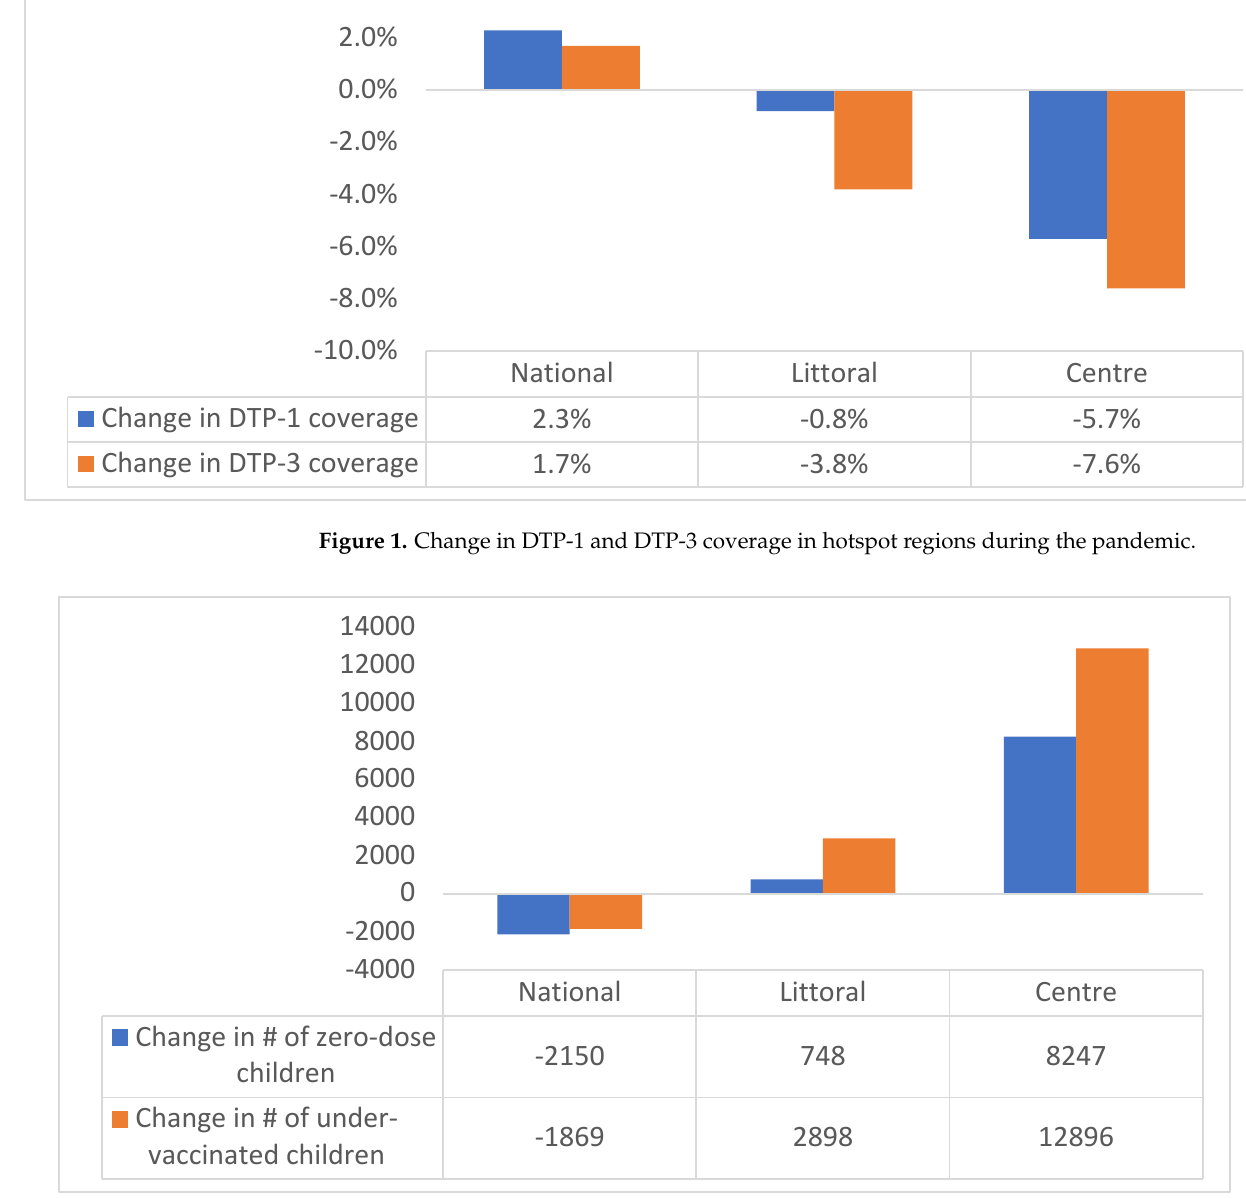
Figure 2. Number of children who missed vaccination in hotspot regions and contrasting national gain in children vaccinated during the